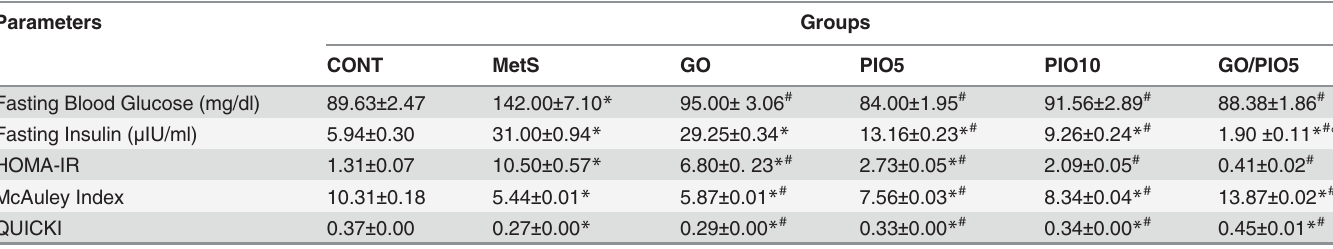
Table 2. Effect of 4 weeks daily oral administration of geraniol (GO; 250 mg/kg), pioglitazone (PIO; 5 and 10 mg/kg), and GO with PIO5 on plasma serum fasting blood glucose and insulin levels, as well as homeostatic model assessment-insulin resistance (HOMA-IR),